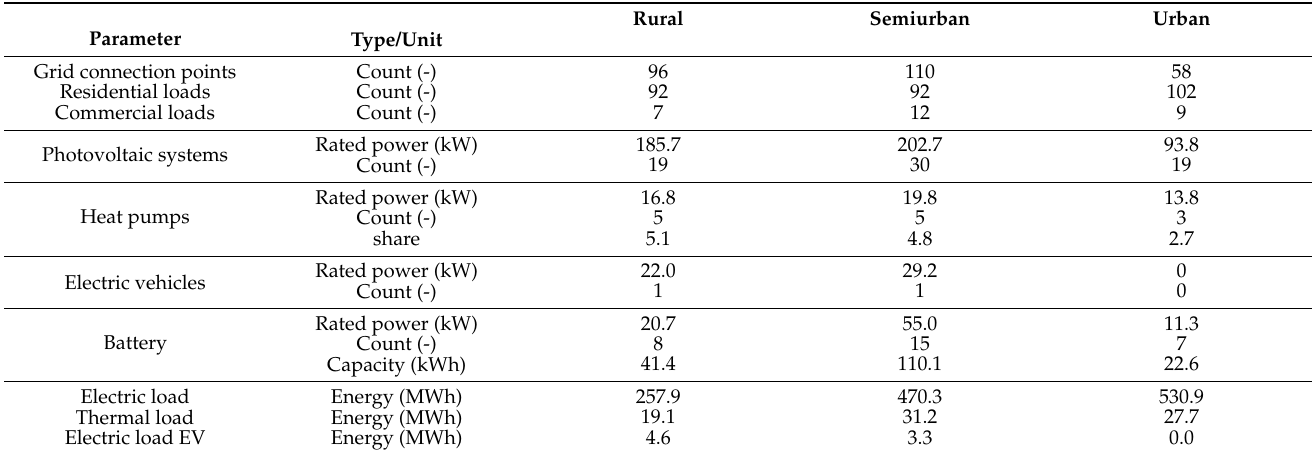
Table A1. Scenario assumptions for scenario year 2020, adapted from [2].